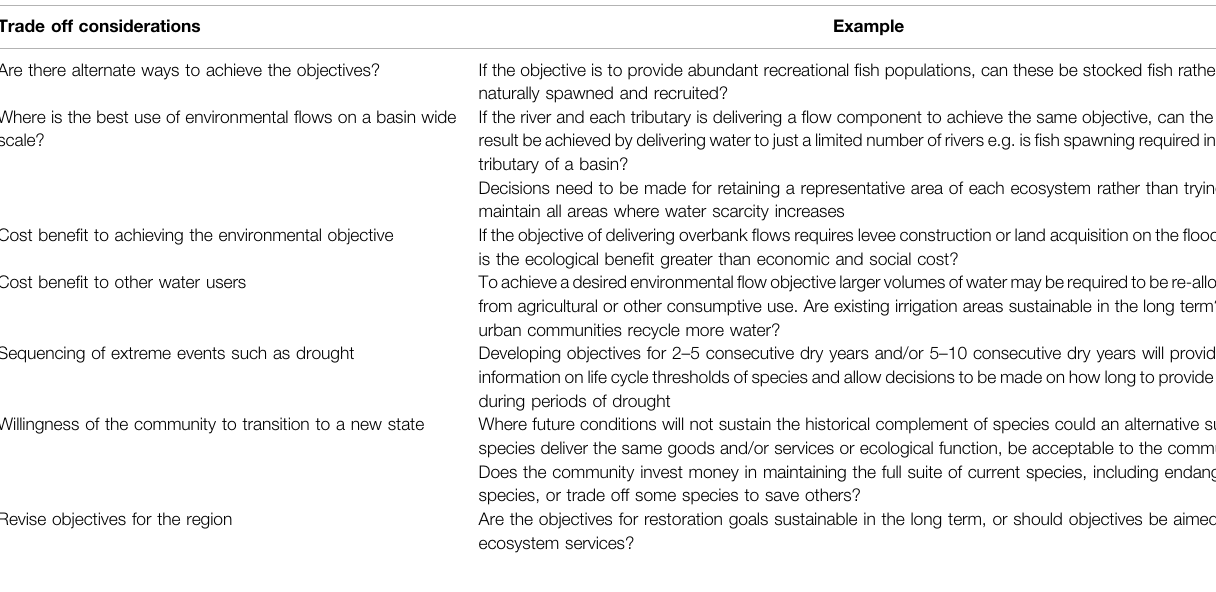
TABLE 3 | Examples of trade off considerations required in setting future environmental fl ow